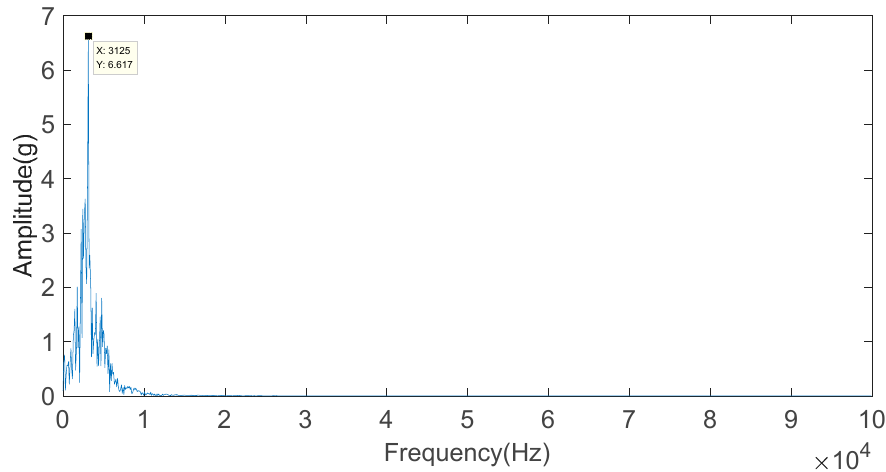
Figure 18. Frequency-domain diagram of the IMF2 component of the engine block vibration signal under a weak knock condition at 5200 rpm.